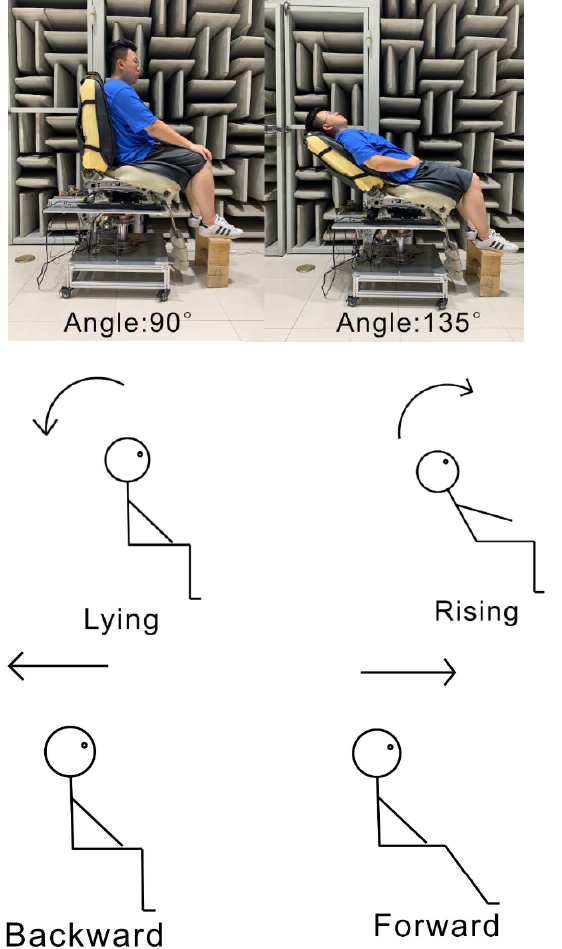
Figure 1. Subject sitting on the automobile seat in the extreme positions of the backrest (left 90°, right 135°). Table 2. The adjustment settings of each speed condition.